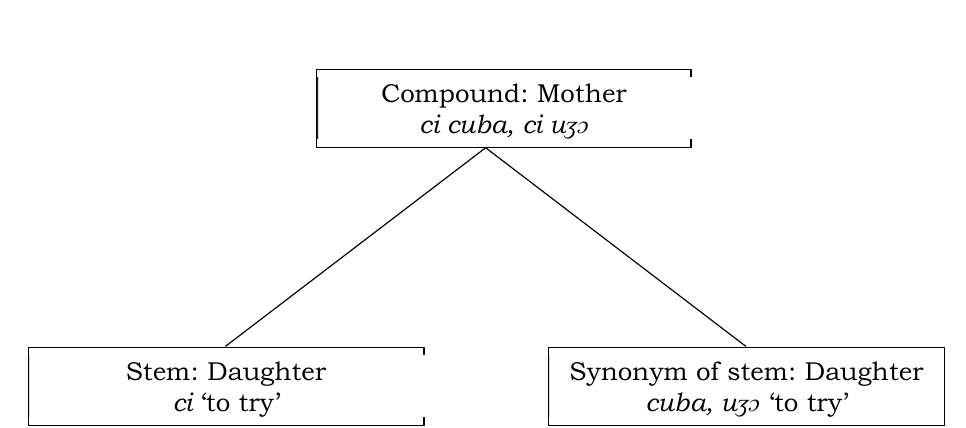
Figure 1. Process of compounding of synonyms in